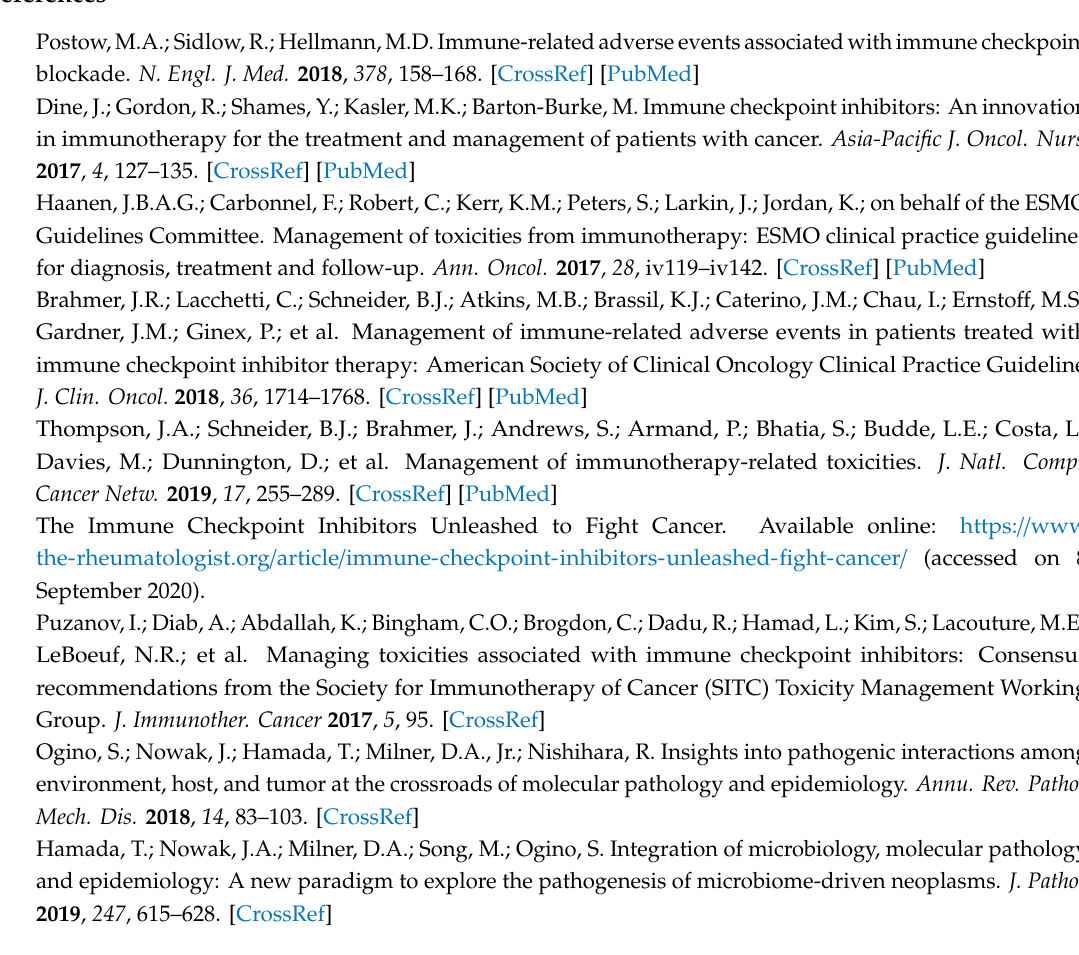
Table S1: Frequency of adverse e ff ects of immune checkpoint inhibitors